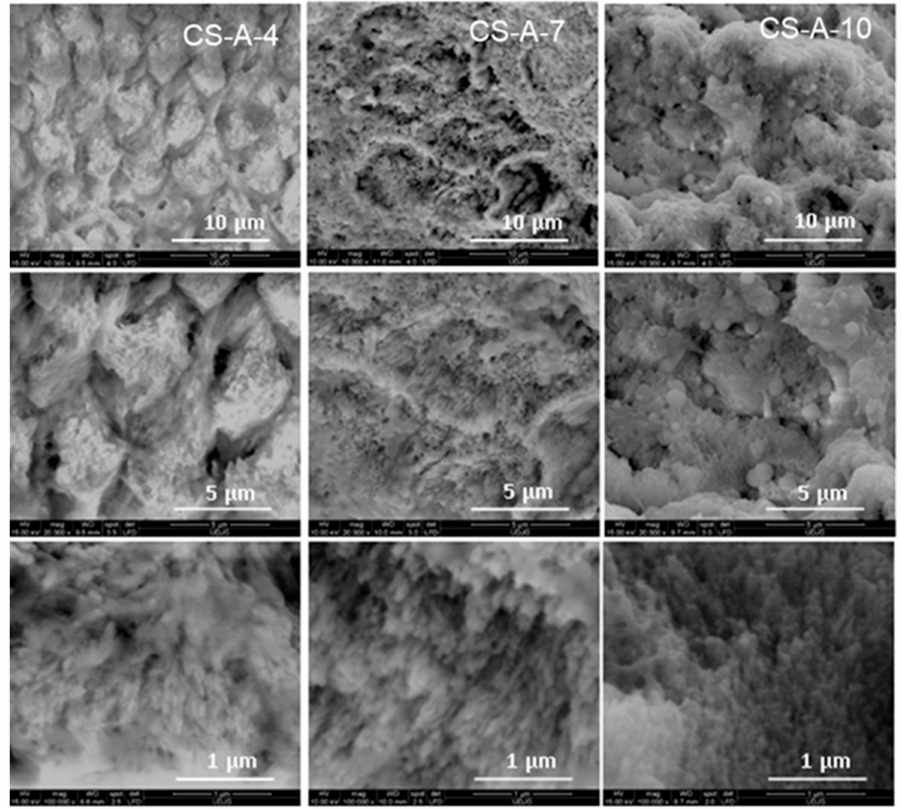
Figure 5. Top-view SEM images of the remineralized acid-etched enamel samples under chitosan– agarose-based hydrogel for four (CS-A-4), seven (CS-A-7), and ten (CS-A-10)